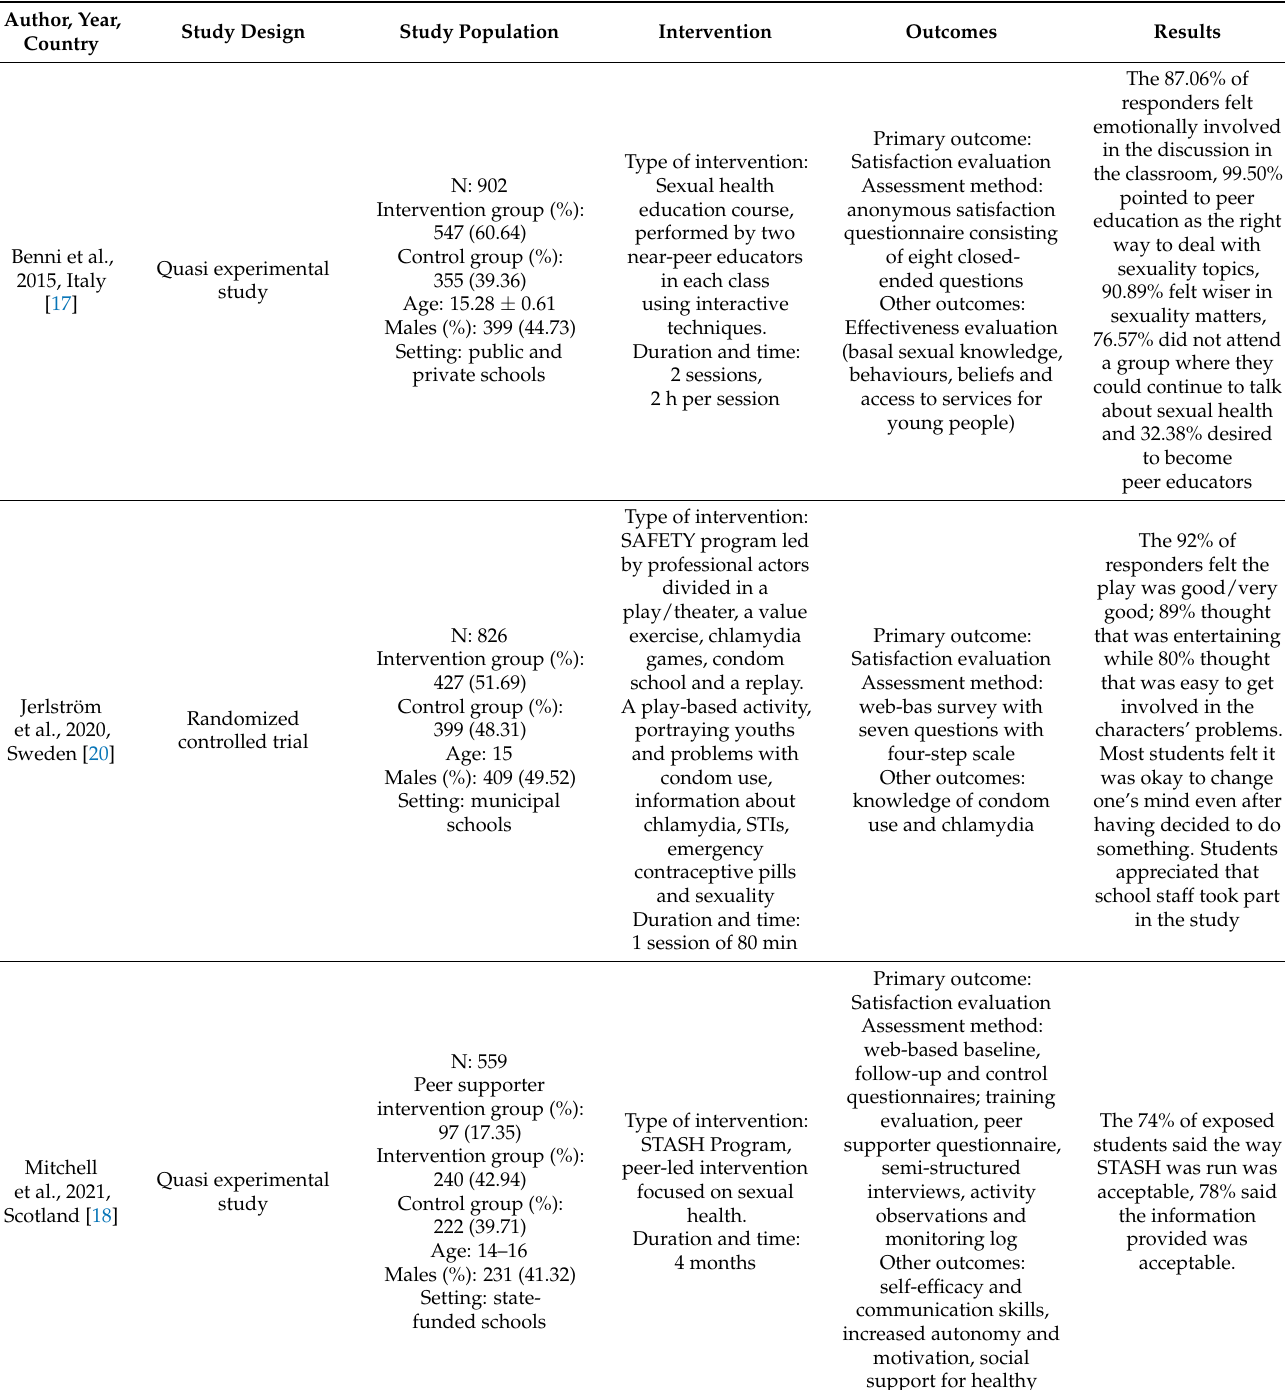
Table 3. Studies included in the